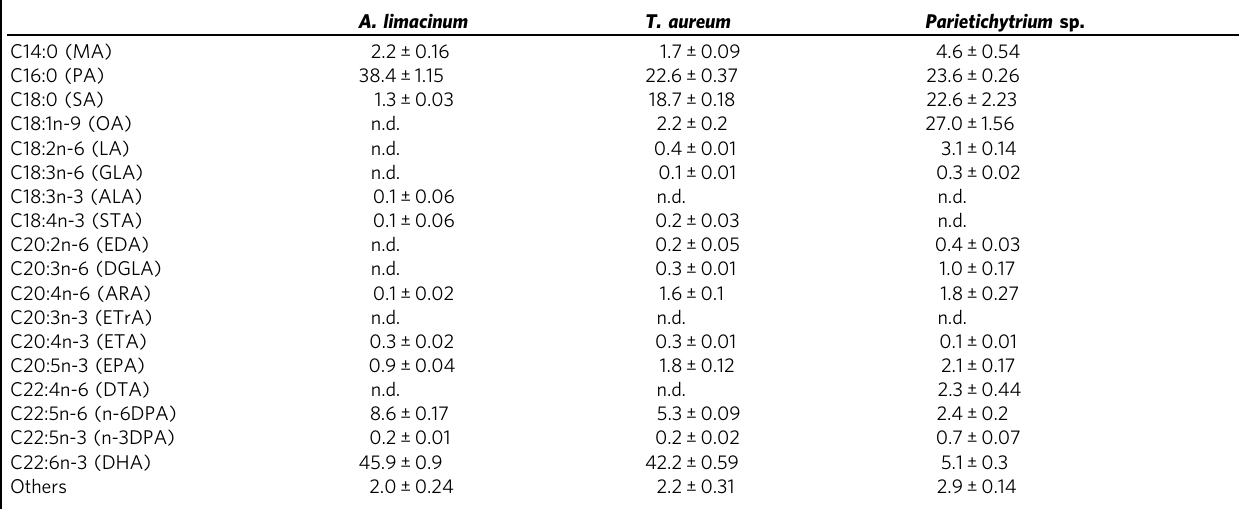
Table 1 Total fatty acid compositions of A. limacinum , T. aureum , and Parietichytrium sp.